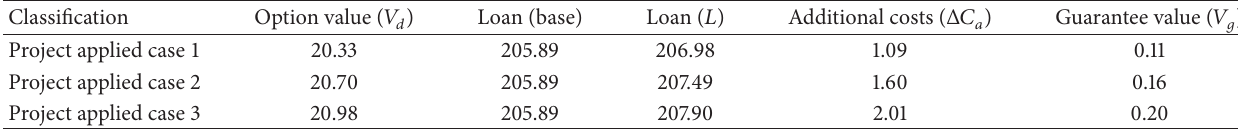
Table 4: Value of guarantee for each case.